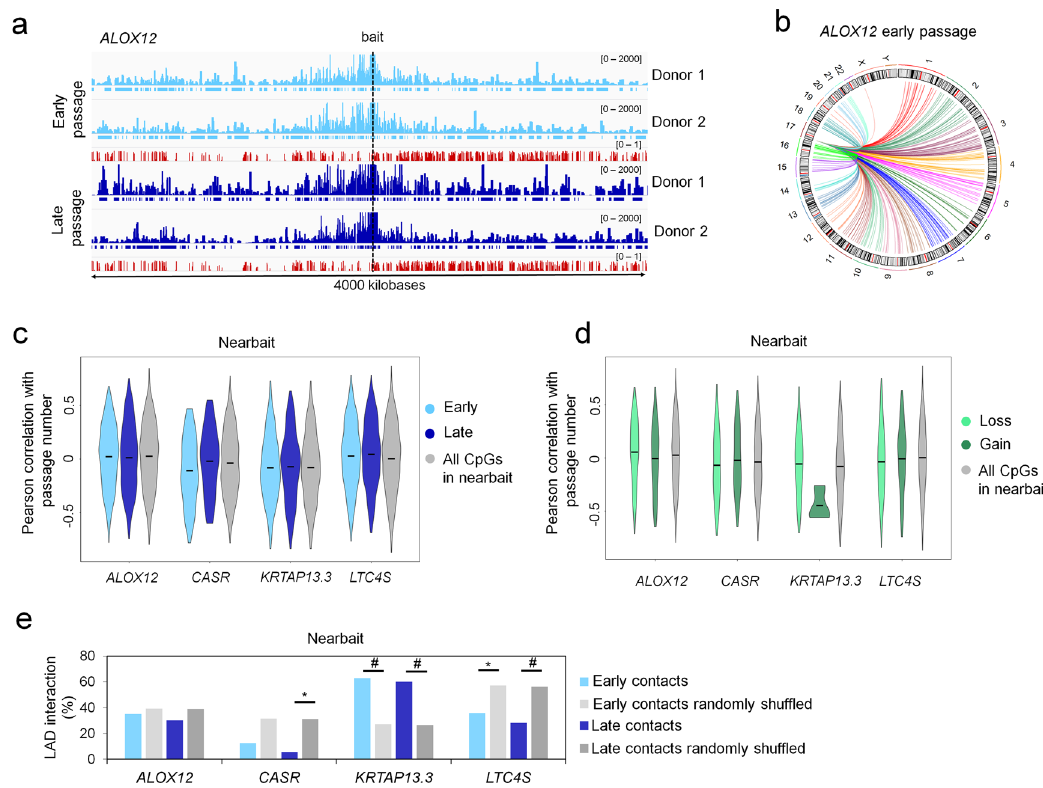
Fig. 5 Circular chromatin conformation capture (4C) of culture-associated CpGs. a Integrative Genomics Viewer (IGV) overview of the bait region of ALOX12 (chr17:4741221-8741221; hg19) in MSCs of two donors at early (P2 and P3, light blue) and late (P7 and P9, dark blue) passage. Sequencing peaks are presented as normalized counts. High-interacting regions called by 4 Cker tool are indicated by horizontal bars beneath the peaks. Mean methylation levels of CpGs on the Illumina 450k BeadChip are depicted for MSCs at early ( n = 5; P2 – P3) and late passages ( n = 5; P7 – P13; GSE37067; red) 22 . b Circos- plot of highly interacting regions across different chromosomes (trans) is exemplarily depicted for ALOX12 (interactions are reproducible in two MSC preparations at early passage). c For each CpG represented on the Illumina 450k Bead Chip the Pearson correlation between DNAm and passage numbers was calculated based on DNAm pro fi les of 63 DNAm pro fi les (Supplemental Table S1). Violin plots show the distribution of these culture-associated DNAm changes at CpGs in the nearbait regions of ALOX12, CASR, KRTAP13.3 , and LTC4S . This was analyzed for 4C interactions in early passaged cells (light blue) or late passaged cells (dark blue) in comparison to all CpGs of the nearbait region (gray; means depicted by black bars). d In analogy to c the violin plots depict the Pearson correlation of DNAm with passage number of CpGs in the signi fi cantly differential contacts between early and late passage cells. e Enrichment of lamina-associated domains (LADs) of a publicly available dataset of human fi broblasts 32 within high-interacting sites (nearbait region) of the four baits compared to the mean interaction frequency of random background regions of the same size (shuf fl ed along the nearbait region 1000 times). Signi fi cance was estimated by Fisher ’ s exact test (* p < 0.05; ** p < 0.01; *** p < 0.001; # p < 0.0001). Raw data of the 4C experiment was uploaded to Gene Expression Omnibus (GEO):